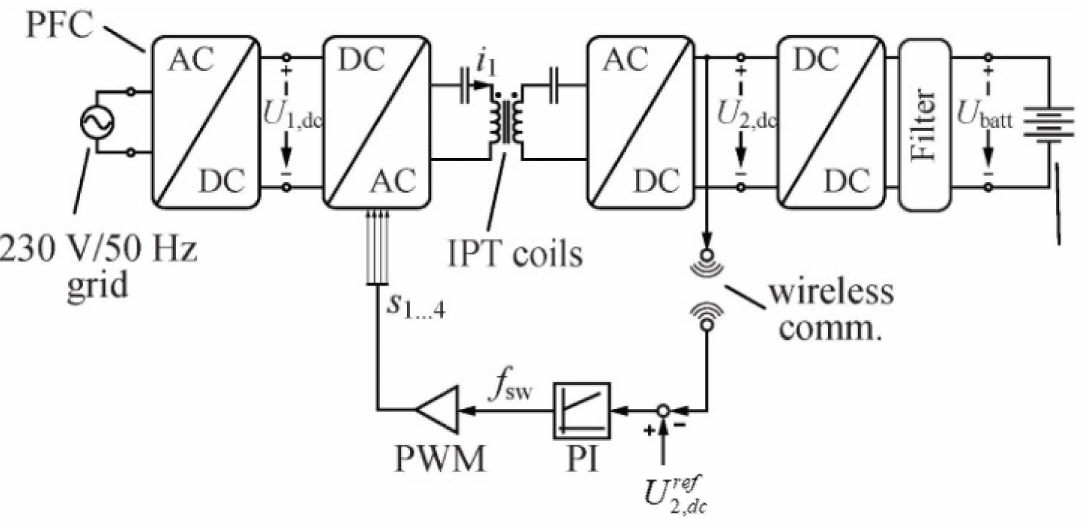
Figure 15. Block diagram of a series-series compensated primary controlled IPT battery charging system [78].